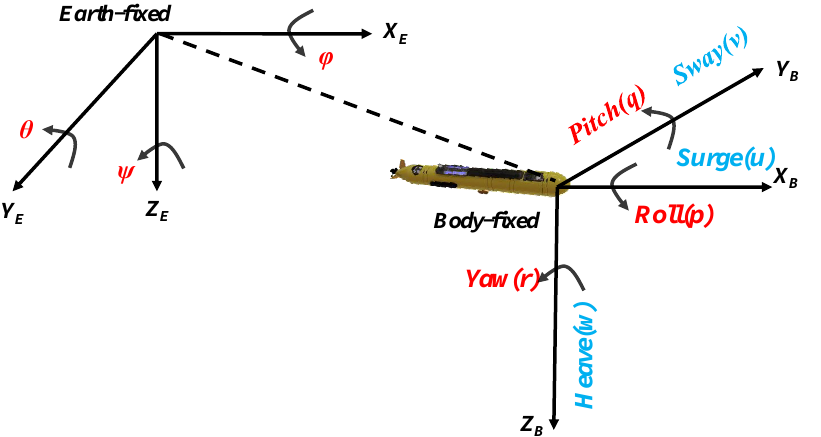
Figure 1. Inertial and motion coordinate system of autonomous underwater vehicles (AUVs), the left is the Earth-fixed coordinate system, the right is the Body-fixed coordinate